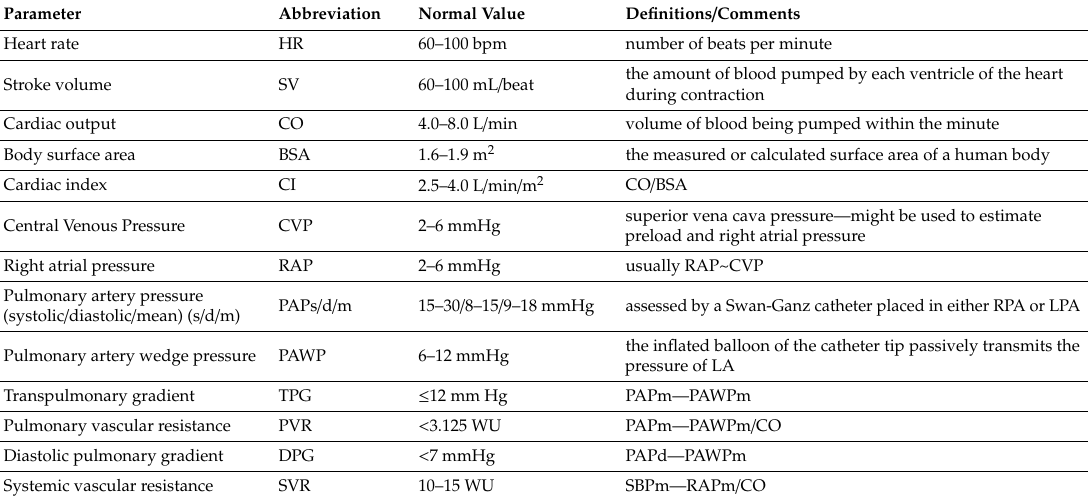
Table legend: SBPm–systemic blood pressure mean, WU–Wood